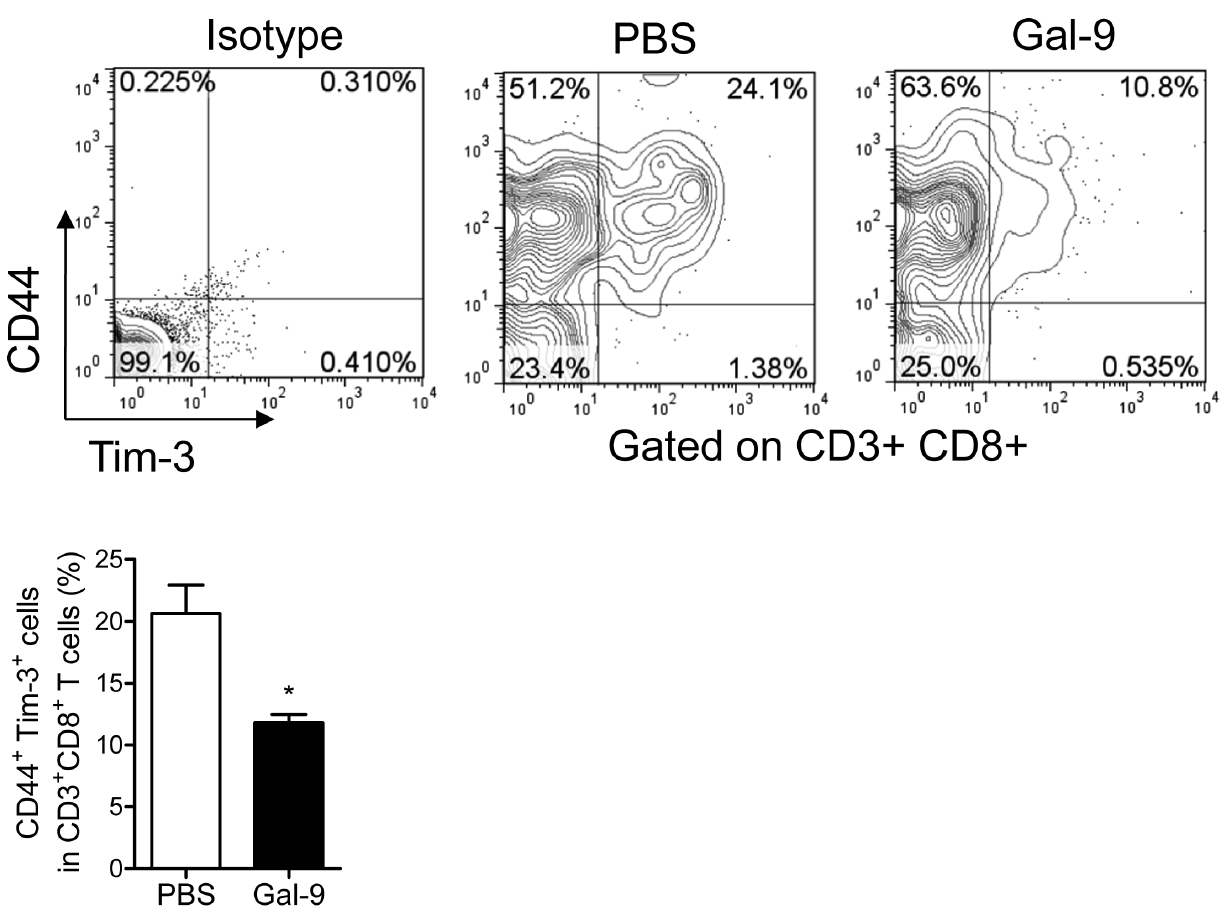
Figure 4. Gal-9 decreases splenic Tim-3 + CD44 + CD8 T cells. Comparison of the percentage of Tim-3 + CD44 + CD8 + T cells between PBS-treated (n=4) and Gal-9-treated (n=4) mice (*, P , 0.05). Representative data of flow cytometric profiles are shown.